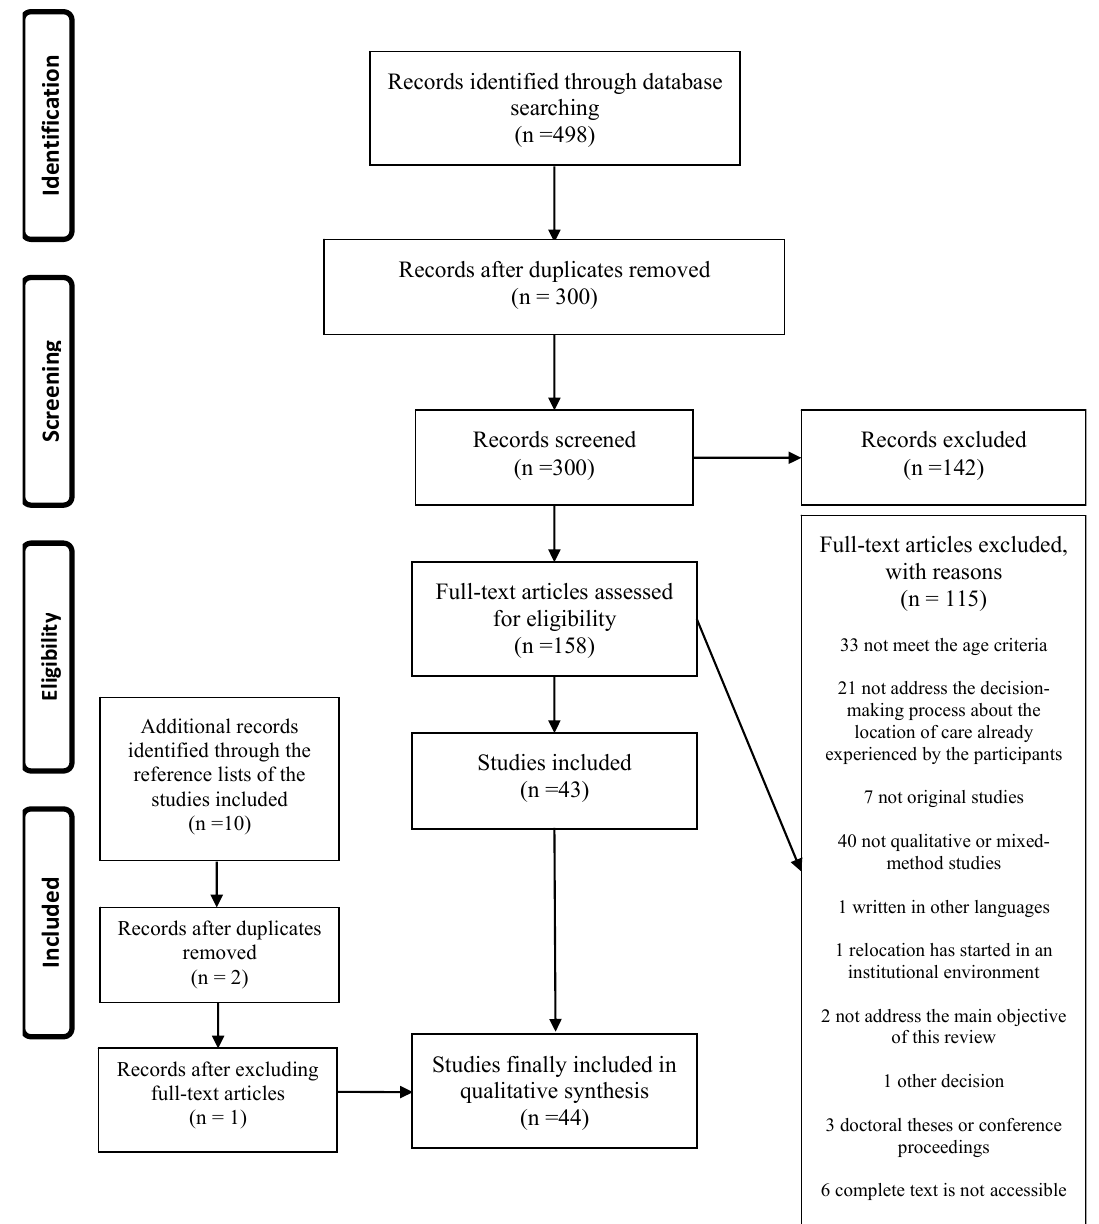
Figure 1. Modification of the Preferred Reporting Items for Systematic Reviews and Meta-Analyses (PRISMA) 2009 flow diagram [15]. Source: own elaboration following the information obtained. (More detailed information about “the identification” can be found in Serrano-Gemes et al. [11]).